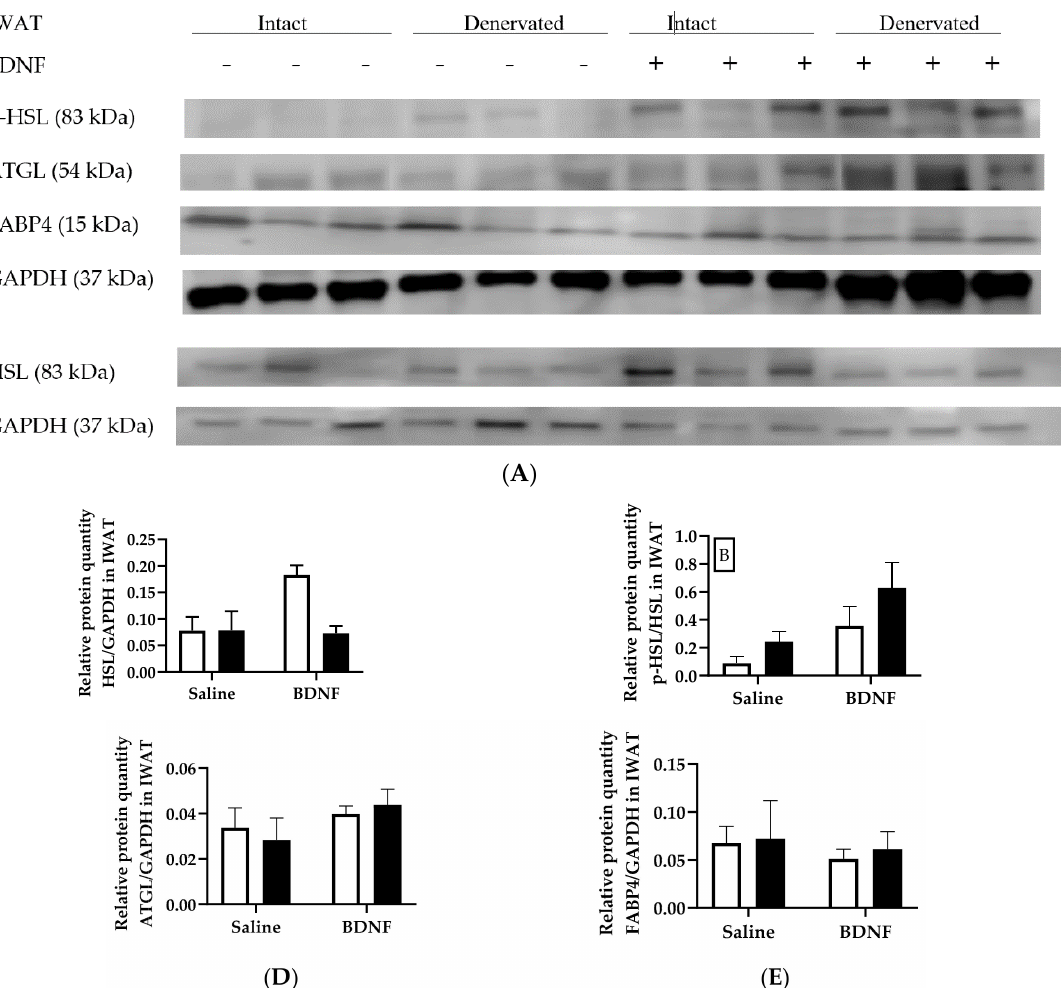
Figure 5. Expression of lipolytic p-HSL, HSL, ATGL, and FABP4 in intact and denervated inguinal white adipose tissue (IWAT) of intracerebroventricular saline- or BDNF-treated rats. Quantifications of p-HSL, HSL, ATGL, and FABP4 were normalized to GAPDH. Quantifications of p-HSL / GAPDH were also normalized to HSL / GAPDH to obtain p-HSL / HSL. ( A ) Representative western blot images of expression of p-HSL, HSL, ATGL, and GAPDH; and quantifications of ( B ) HSL / GAPDH, ( C ) p-HSL / HSL, ( D ) ATGL / GAPDH, and ( E ) FABP4 / GAPDH in intact (open bar) and denervated (filled bar) IWAT of saline- or BDNF-treated rats. Two-way ANOVA with the factors “innervation” (N; intact vs. denervated) and “BDNF” (B; icv saline vs. BDNF treatment) and multiple comparisons post hoc Tukey’s test were used to compare relative protein quantities. * Represents significant di ff erences relative to saline-treated rats ( p <